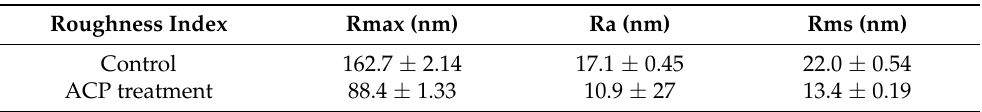
Figure 9. Atomic force microscope images of control and ACP−treated film at 30 kV for 3 min. ( a ) Untreated soy protein film. ( b ) Soy protein film treated by ACP at 30 kV for 3 min. Untreated soy protein film was considered as the control. The amount of soy protein was 10% and glycerol was 2.8%. Table 3. Roughness parameters for the control and ACP–treated samples with the amount of soy protein being 10% and glycerol being 2.8%.